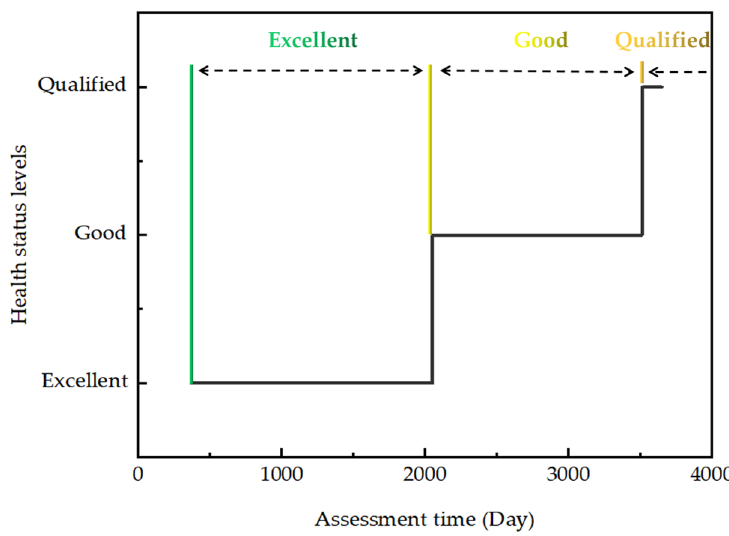
Figure 8. Chart of component health status level changes.